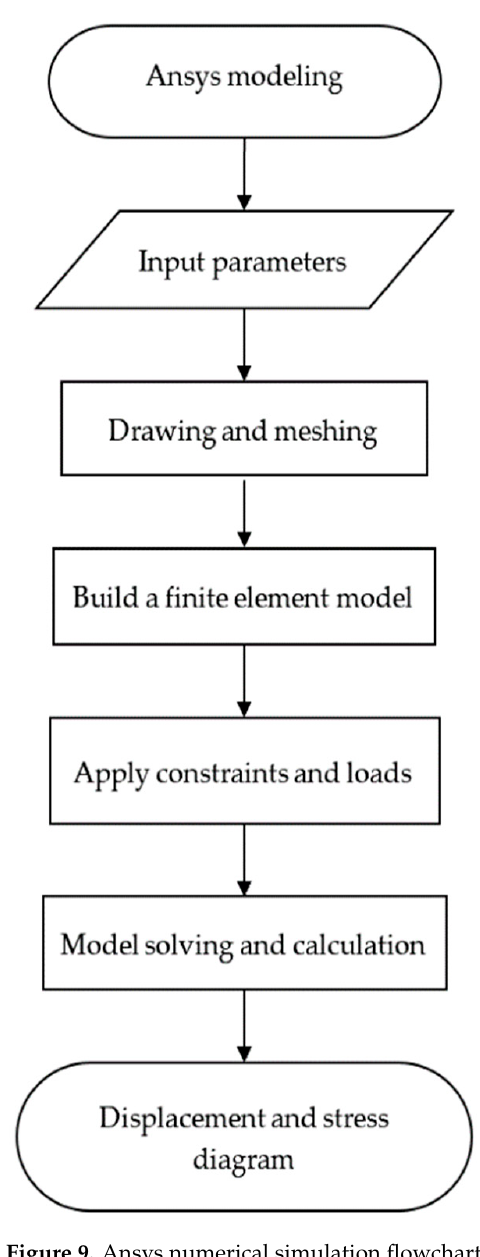
Figure 9. Ansys numerical simulation flowchart. The Cartesian coordinate system was used for modeling, and the length of the rod was the Z-axis. The cross section of the rod was H-shaped steel, and the height and width of the H-shaped steel cross section were X-axis and Y-axis, respectively. The model uses a three-dimensional elastic beam element beam188 element. Two points were selected to determine a line, and then the mesh was divided into 100 units. Constraints were imposed on both ends of the model, with UX, UY, UZ, and ROTZ at the lower end, and UX, UY, and ROTZ at the upper end, forming the boundary conditions of the simply supported constraints. The meshing and constraint drawing of H-section bars is shown in Figure